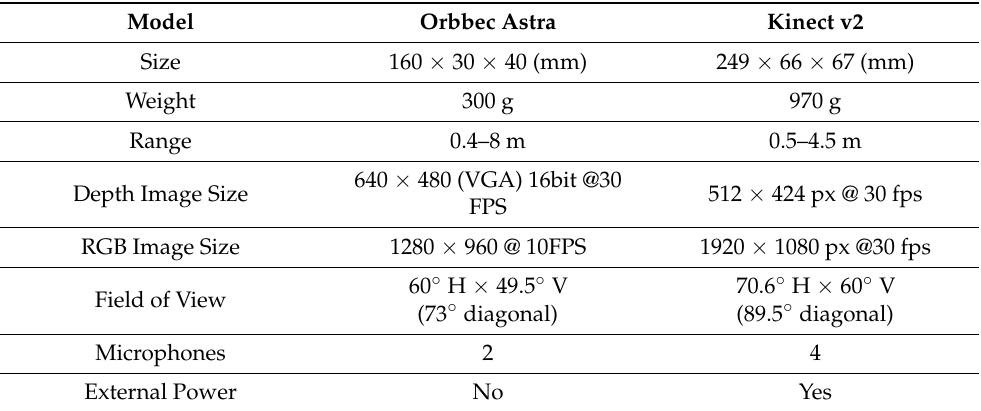
Table 2. Orbbec Astra and Kinect v2 specifications